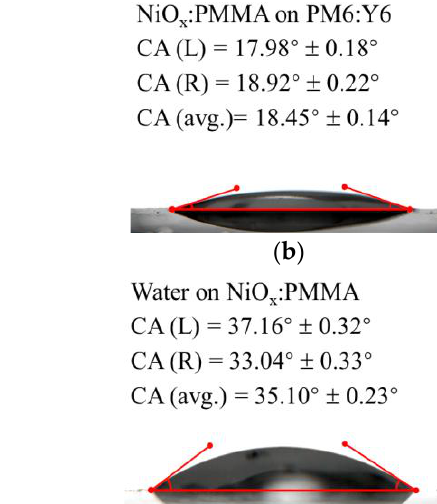
Figure 6. ( a ) Atomic force microscopy (AFM) height image of NiO x HTL film. ( b ) AFM height image of NiO x :PMMA HTL film. ( c ) Top-view scanning electron microscopy (SEM) image of NiO x HTL film. ( d ) Top-view SEM image of NiO x :PMMA HTL film.